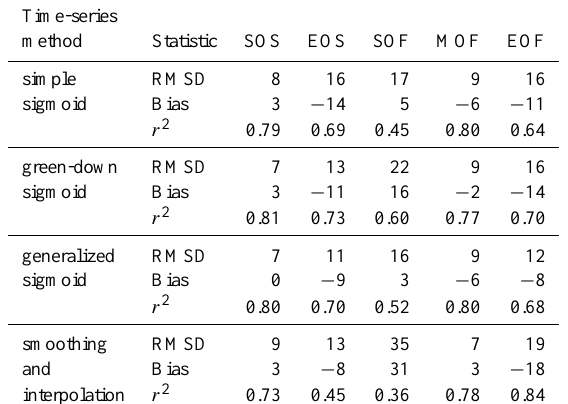
Table 3. Statistics comparing visual assessment to phenology de- rived from near-surface image processing. Visually assessed dates were compared to time-series methods as follows: the date when the majority of trees started leafing out was compared to SOS, the date of canopy maturity to EOS, the date of first color change to SOF, the date of brightest fall colors to MOF, and the date of leaf loss to EOF. Near-surface imagery dates were estimated from greenness, except for SOF, MOF, and EOF dates in the smoothing and inter- polation approach, which were estimated from redness. Statistics include RMSD and bias in units of days, and r 2 for the comparison of corresponding dates and methods across all site years. Bias is calculated relative to time-series estimates, so a negative bias indi- cates that the corresponding visual assessment is later. 73 site years of data were used in this